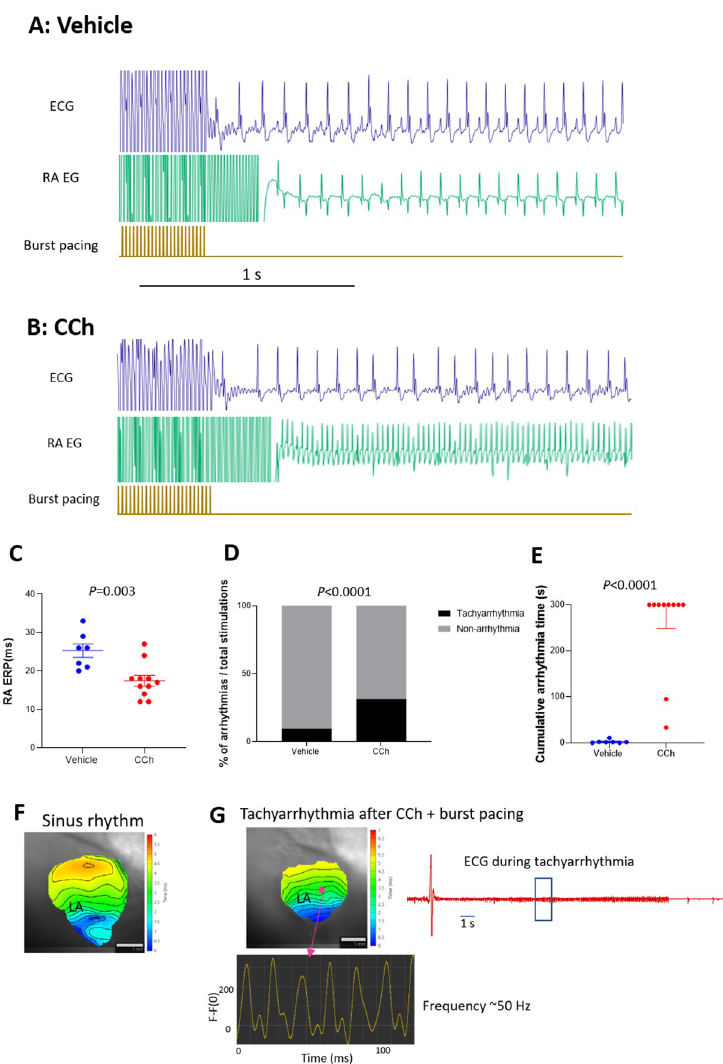
Fig 1. Characteristics of CCh + burst pacing-induced tachyarrhythmia in C57BL/6 mice and in isolated hearts. A and B: representative ECG and RA EG traces after 50 Hz burst pacing in vehicle-treated and CCh-treated (0.3 mg/kg, ip) mice, respectively. C: Right Atrial effective refractory period (RA ERP) in vehicle-treated and CCh-treated groups (n = 7 and n = 11, respectively). Each point indicates individual animal data, and lines represent mean ± SEM. D: % of total burst pacing stimulations that resulted in atrial tachyarrhythmias in each group. E: Cumulative atrial tachyarrhythmia time in vehicle and CCh groups (n = 7 and n = 11 respectively). Each point indicates individual animal data, and lines represent median ± IQR. F: Representative activation map during sinus rhythm before CCh treatment. LA activation starts from the lower right and propagates to the upper left. G: An activation map of the same heart after CCh and burst pacing. The LA shows an induced tachyarrhythmia with an activation pattern that is very similar to sinus rhythm, but with high and regular frequency (~50 Hz). Isolated heart ECG of self-terminated tachyarrhythmia is also shown. Similar observations were obtained from 5 out of 5